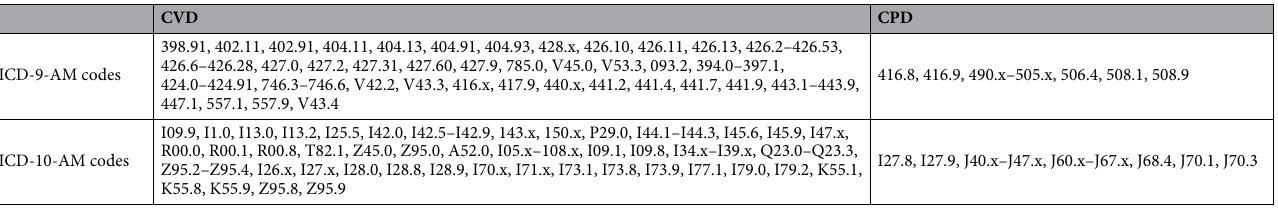
Table 1. ICD-9-AM and ICD-10-AM codes for cardiovascular disease (CVD) and chronic pulmonary disease